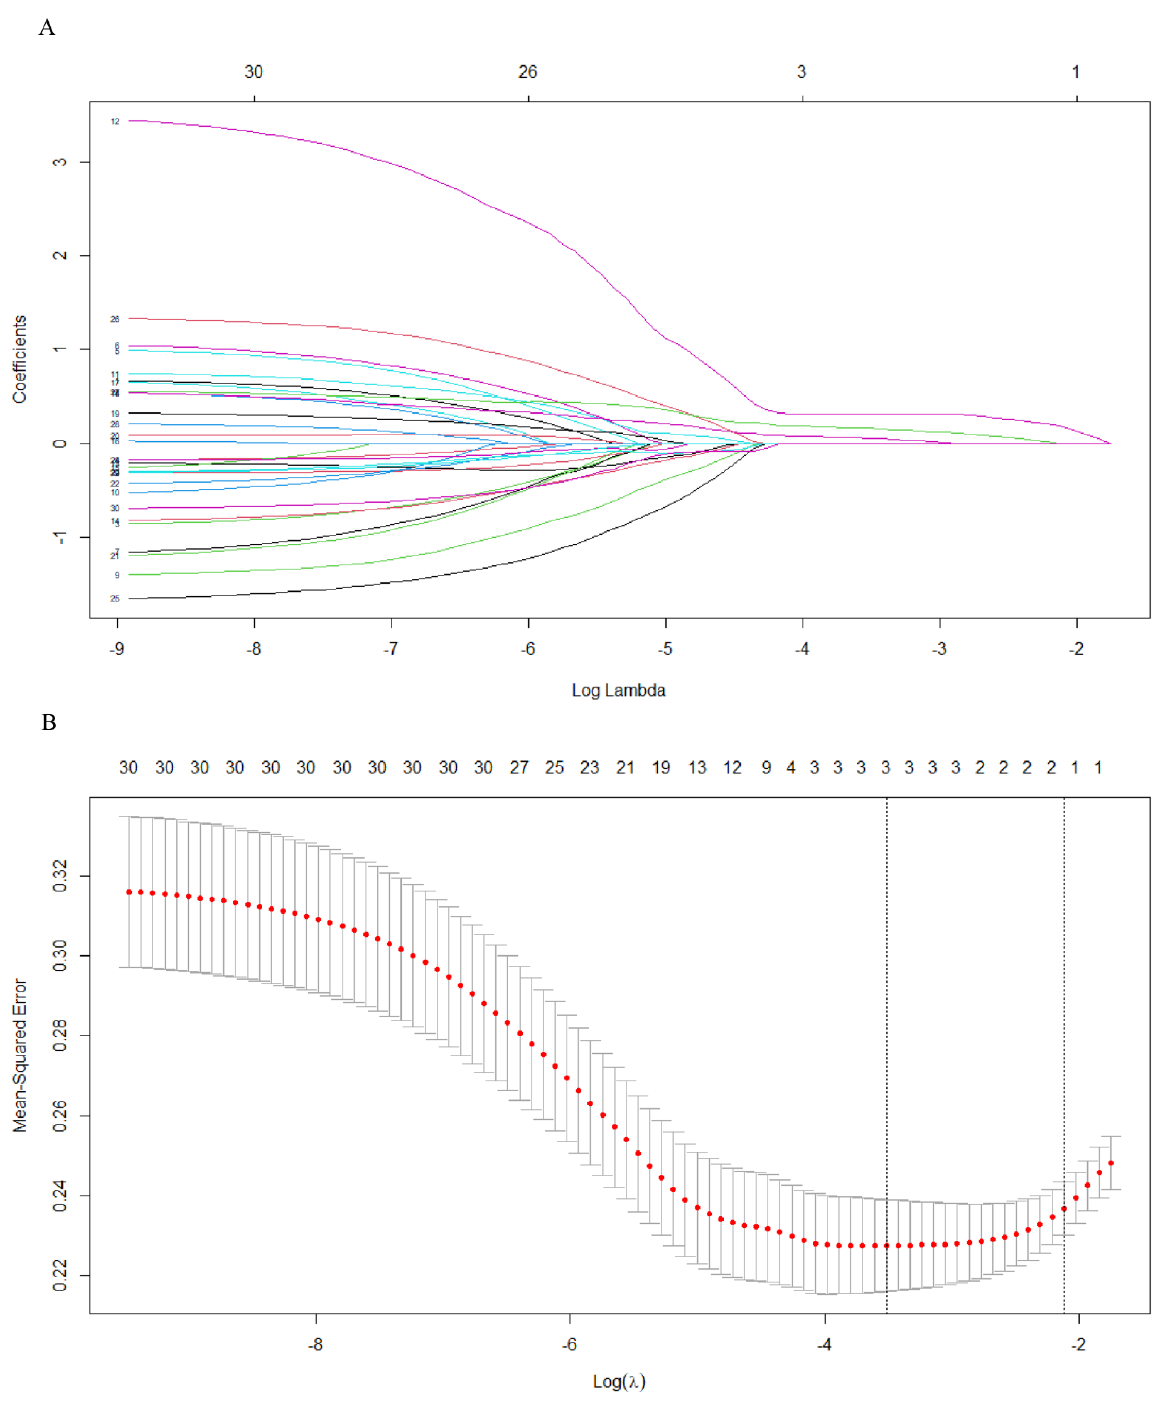
Figure 6. ( A ) The distribution of least absolute shrinkage and selection operator coefficients, biased by partial likelihood. Minimum partial likelihood deviation is indicated by the vertical dashed line. ( B ) LASSO coefficient distribution for 30 genes associated with each other.